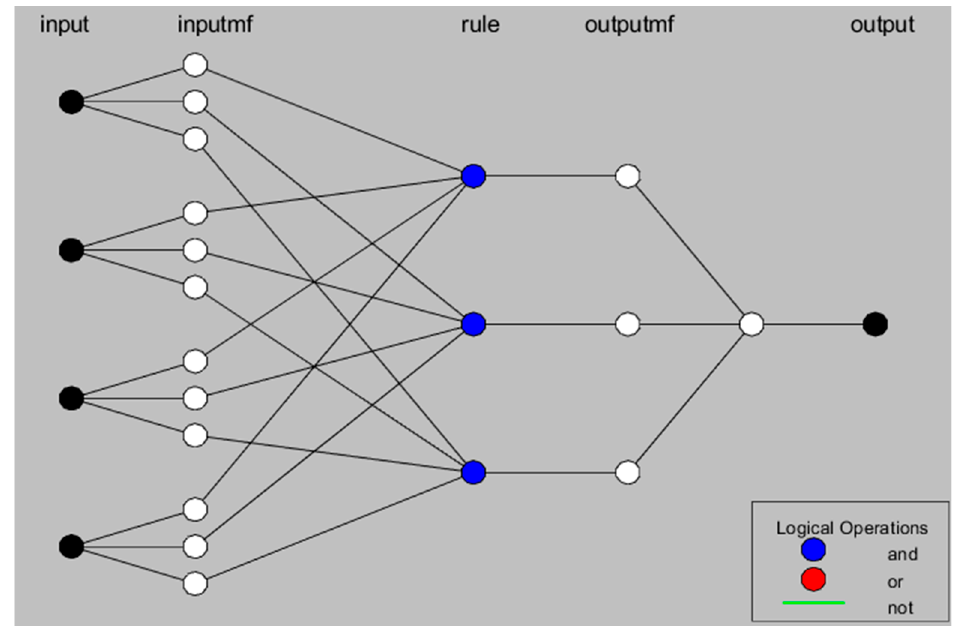
Figure 19. ANFIS structure developed using Subtractive clustering.